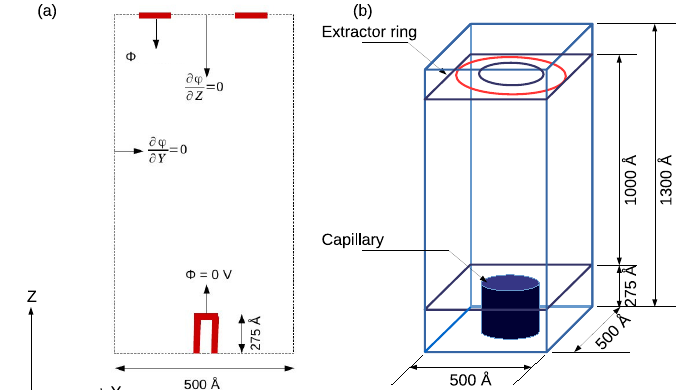
Figure 5. Boundary conditions and isometric projection of the simulation domain used for the MD electrospray simulations. ( a ) Boundary conditions; ( b ) Isometric projection.